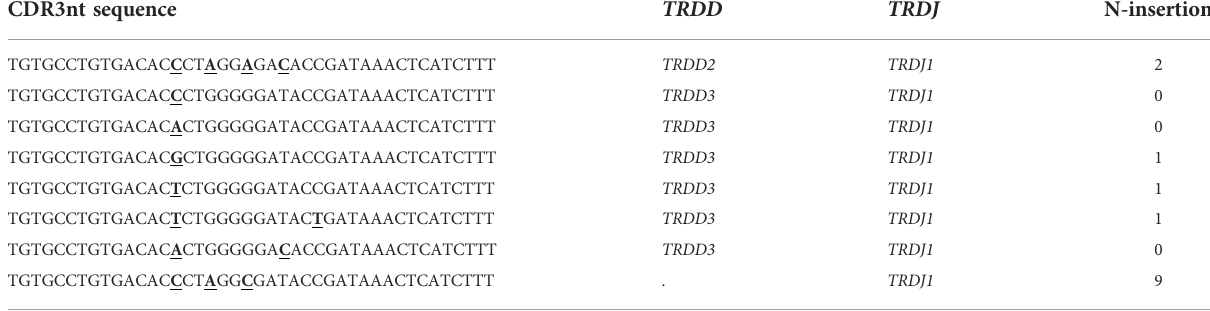
TABLE 1 CDR3aa “ CACDTLGDTDKLIF ” corresponding CDR3nt sequences for individual SA62. CDR3nt sequence